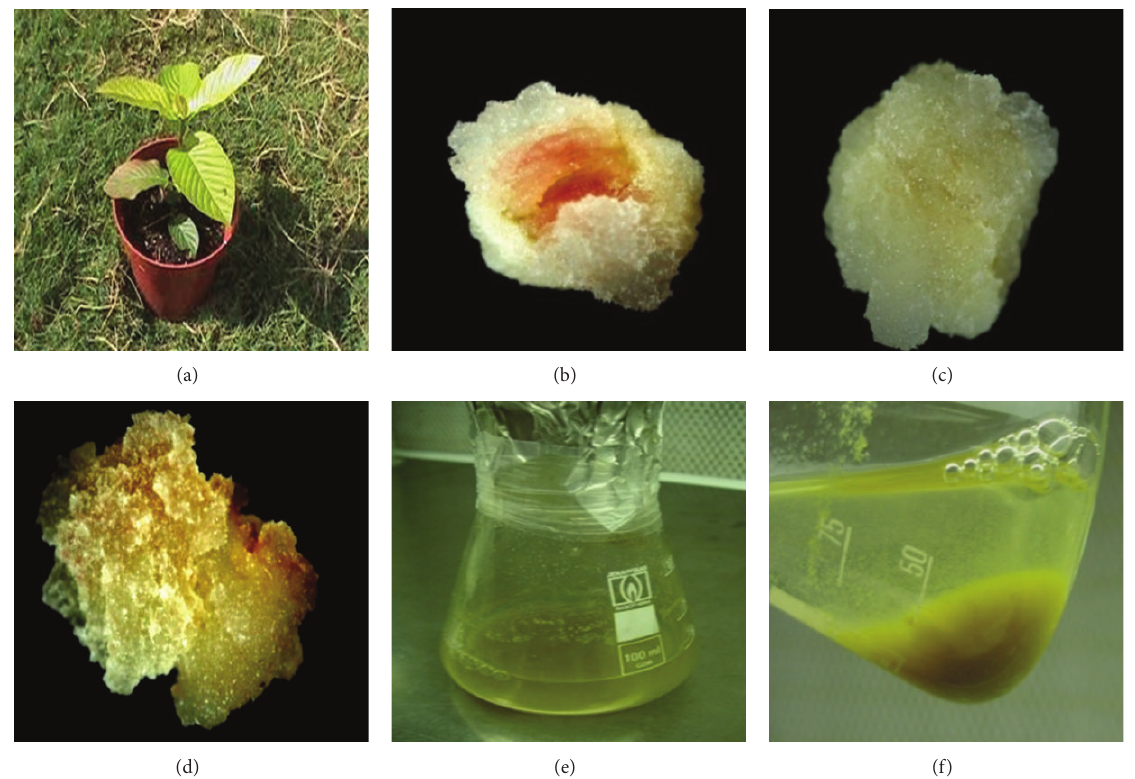
Figure 2: (a) Mitragyna speciosa tree, ((b)–(d)) callus of Mitragyna speciosa , and ((e)-(f)) Mitragyna speciosa suspension culture.